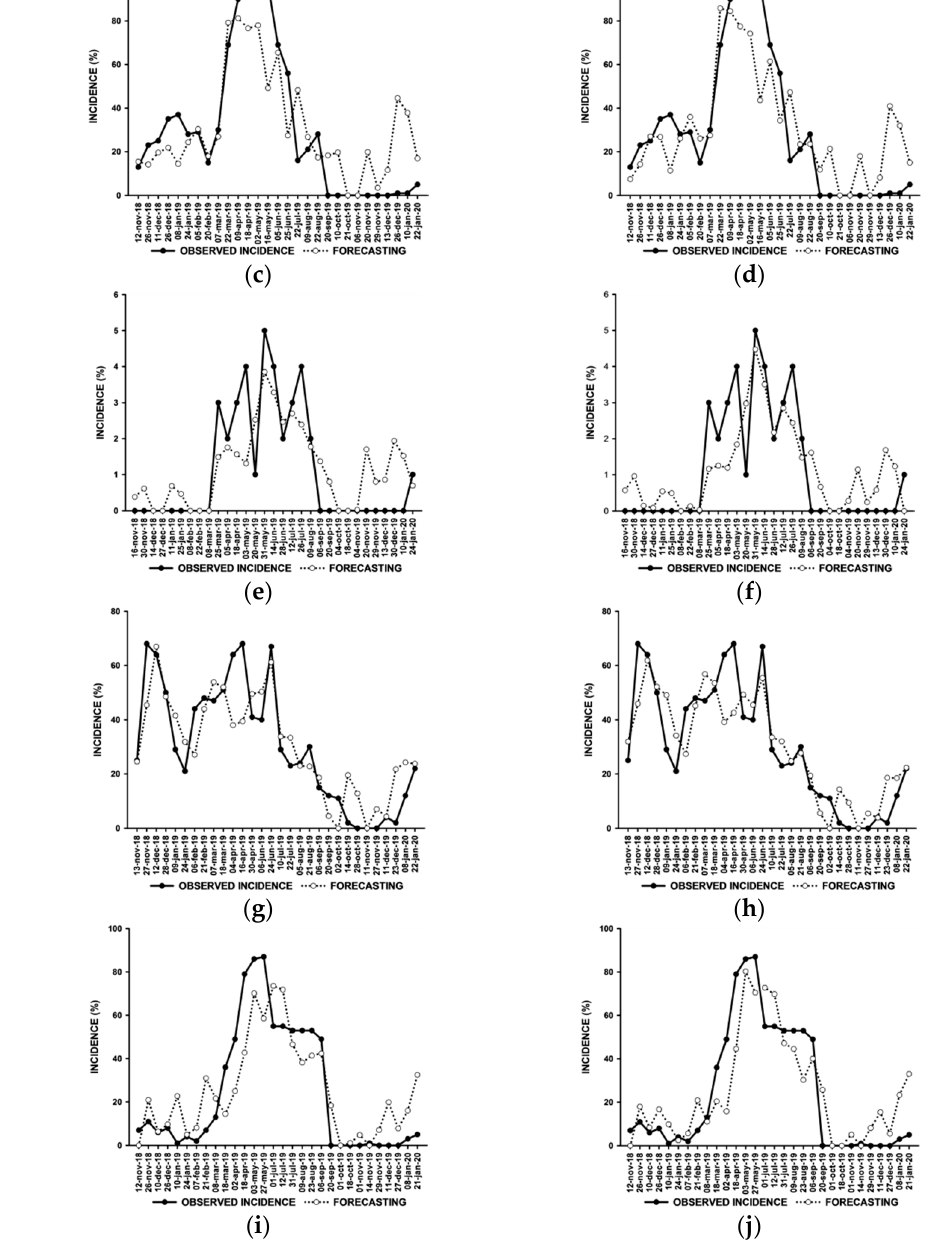
Figure 4. Performance of the best fitted models with forecast estimates of coffee leaf rust compared to field observed data: ( a ) Carmo do Rio Claro, model 15–45 DBRI (Days before rust incidence) with